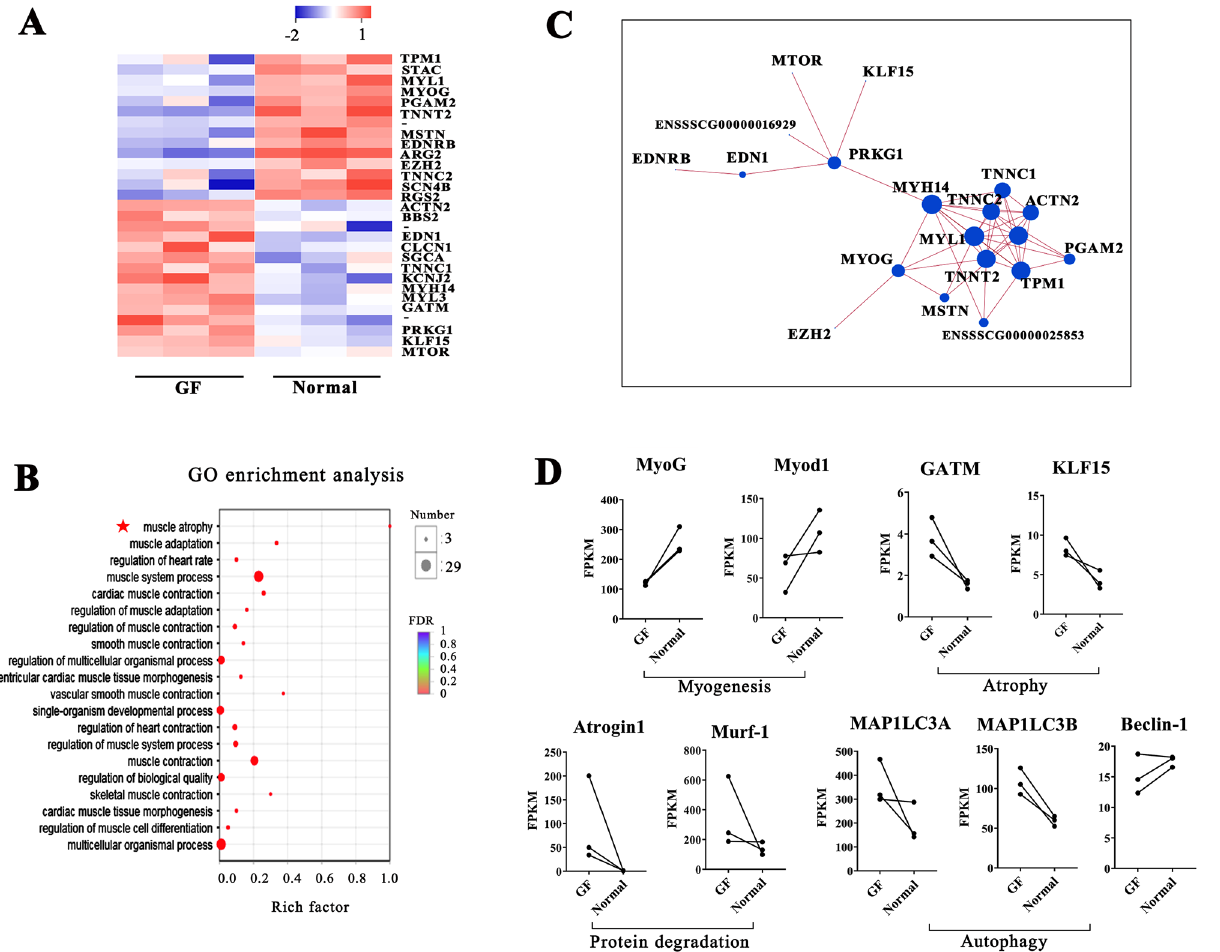
Figure 5. DEGs related to muscle atrophy, protein degradation and muscle autophagy. ( A ) Twenty-nine DEGs were enriched in the GO term "muscle system process". ( B ) Functional annotation for the twenty-nine muscle- related genes. ( C ) Protein interaction network constructed by twenty-nine genes involved in the muscle system. ( D ) Changes in key genes involved in myogenesis, muscle atrophy, protein degradation and muscle autophagy in GF